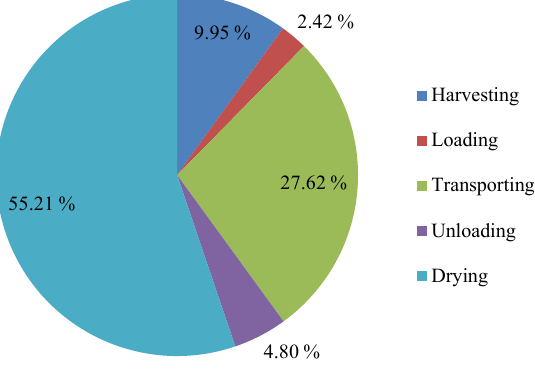
Fig. 3. The prime cost structure of biomass of grass (Technology